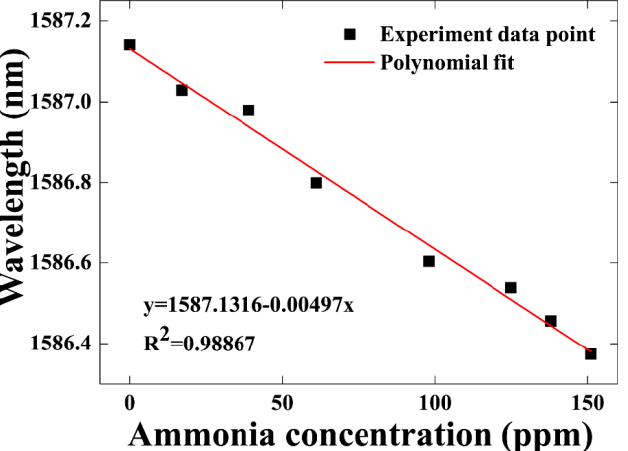
Figure 11. The wavelength shift as a function of ammonia gas concentration from 0 to 151 ppm. In order to investigate the reproducibility and reversibility of the proposed sensor, we repeatedly injected and extracted the ammonia gas with a concentration of 200 ppm into the gas chamber at a temperature of 25 ◦ C. The transmission spectrum was recorded at intervals of 50 s to determine the dynamic behavior of the gas sensor. After the transmission spectrum reached a stable state, indicated when the wavelength of the interferometer minimum was no longer shifting, the next fill or discharge of ammonia gas took place. We recorded the wavelength shift of the resonant dip during two periods of ammonia gas fill and discharge, as shown in Figure 12. The results indicate that the dynamic response rising time (t r ) and falling time (t f ) of the sensor are about 5 and 7.5 min for the two periods, respectively. These repeated cycles of exposure to 0 and 200 ppm of NH 3 gas demonstrate that the rising and falling time are not very fast, but the sensor exhibits good reversibility. The response and recovery time of the sensor are determined by the thickness of the GO layer, the diameter of the tapered fiber and the rate of ammonia gas mixing in the chamber on injection or expulsion.